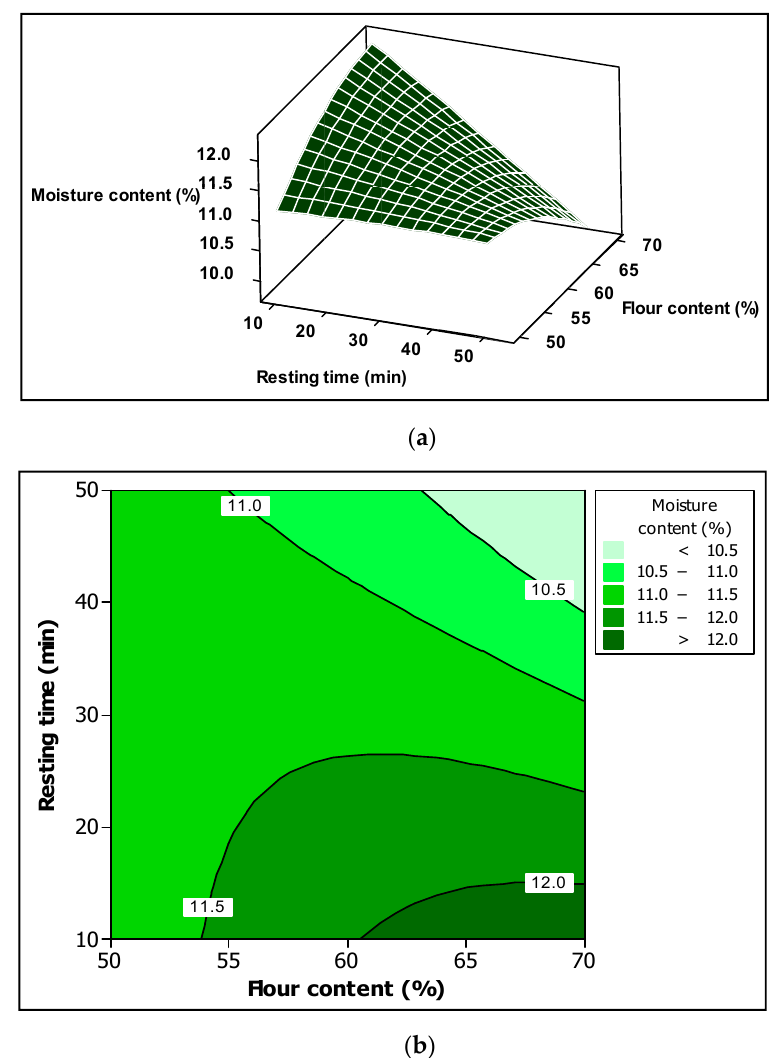
Figure 4. ( a ) Surface plot; ( b ) contour plot of flour content vs. resting time for moisture content.